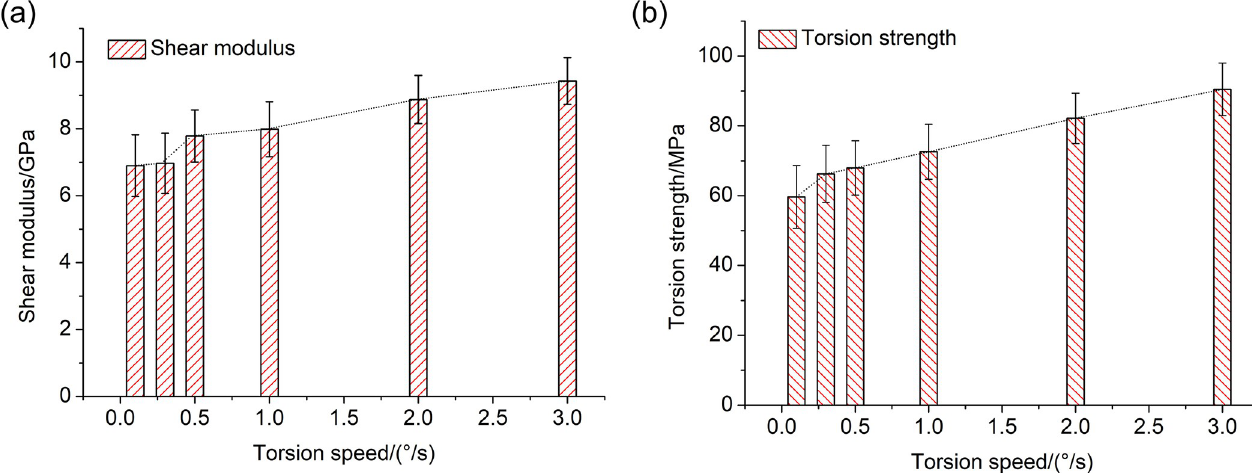
Fig 7. The shear modulus and torsion strength of bone specimen under single torsion load with different torsion speeds (a) Shear modulus (b) Torsion strength.